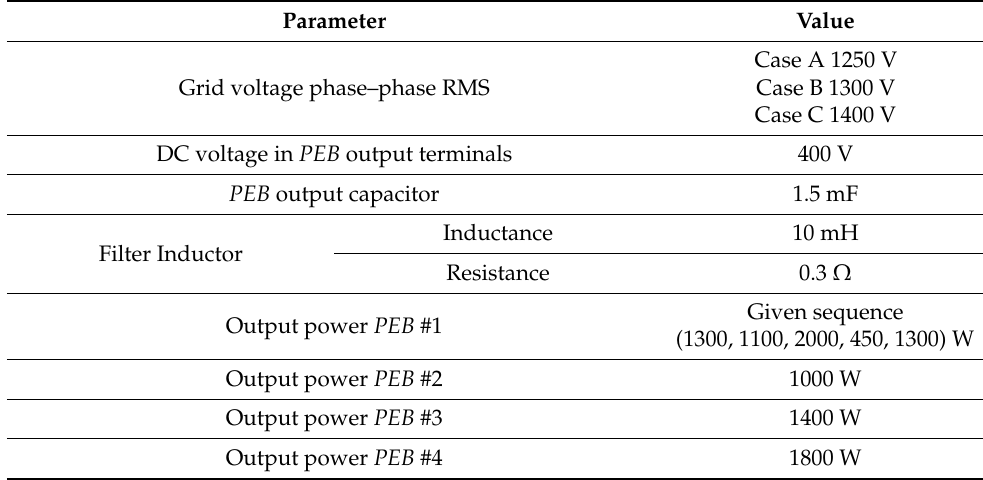
Table 2. Parameters used for the